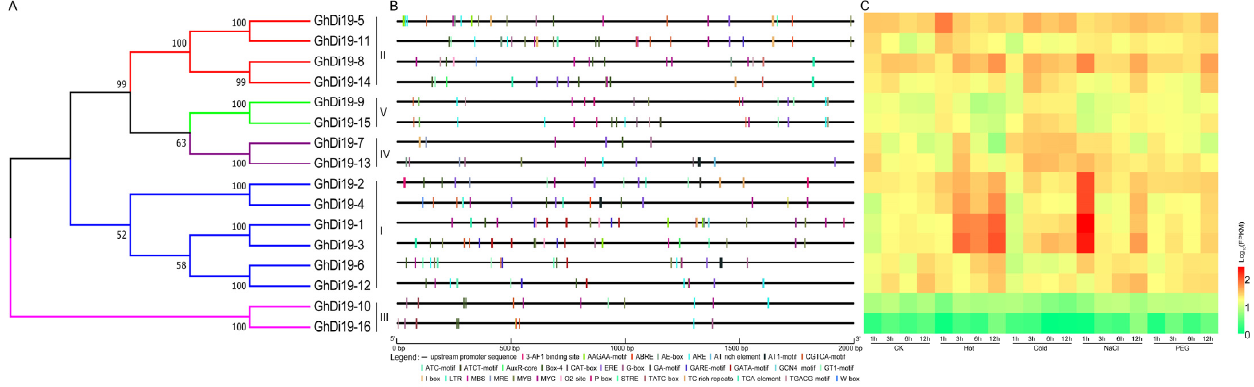
Figure 3. Conserved promoter cis-element and expression profile analysis of GhDi19s . ( A ) Phylogenetic tree of GhDi19s. A neighbor-joining (NJ) phylogenetic tree was built with MEGA 7.0, and the bootstrap values from 1000 replicates are indicated at each branch. ( B ) Conserved promoter analysis of GhDi19 genes. Different cis-elements in the 2000bp promoter region upstream of Di19 gene are marked with different color boxes. ( C ) RNA-sequence data analysis of GhDi19s under different abiotic stresses (cold, hot, PEG, and NaCl). Transcriptomic data normalization and visualization was performed. The color scale in the lower right corner of the heatmap represents the fragments per kilobase million (FPKM) values, which were standardized by log10.